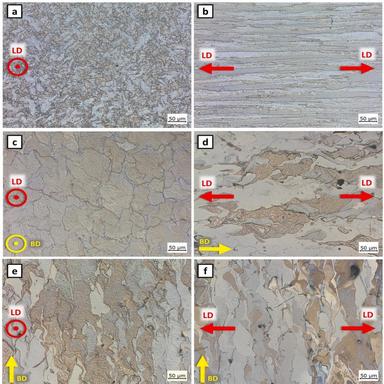
Microstructural analysis of "G-A bar.m" (a) section perpendicular and (b) parallel to load direction; of "AM.m.V" (c) section perpendicular and (b) parallel to load direction; and finally of "AM.m.H" (d) section perpendicular and (b) parallel to load direction. "LD" red arrows indicate the load direction and "BD" yellow arrows indicate the building direction.